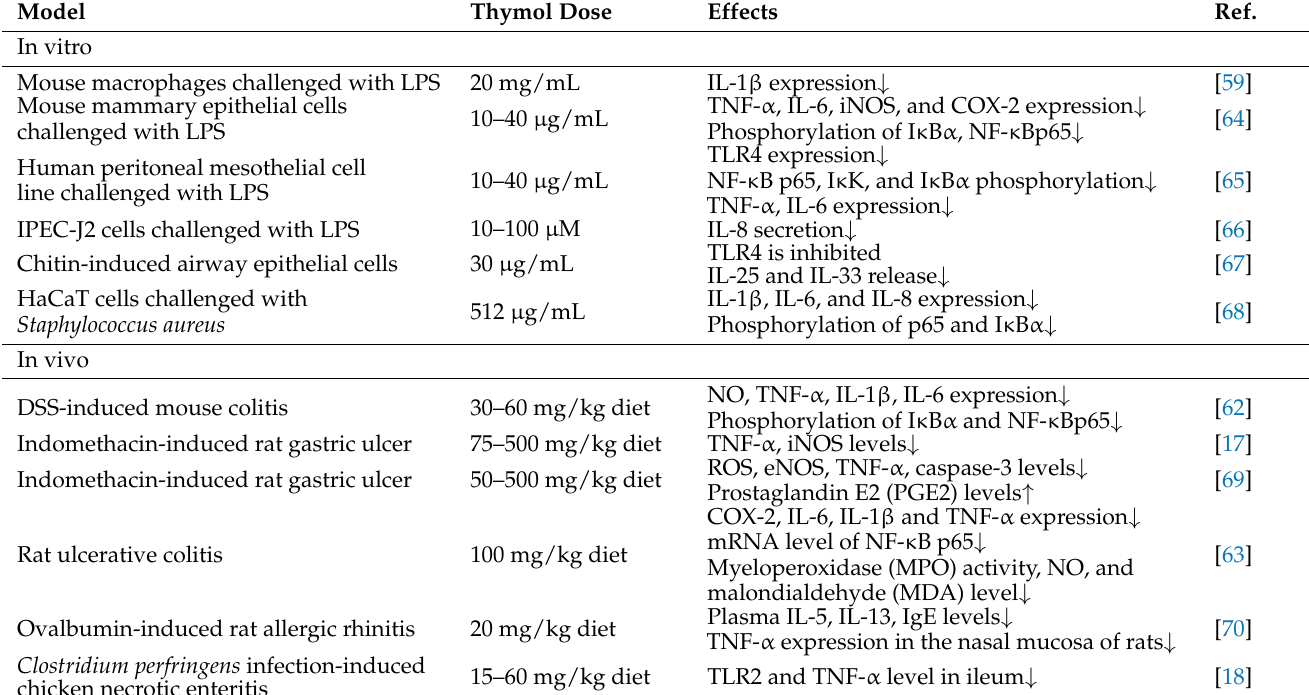
Table 2. Summary of the effect of thymol in different inflammation